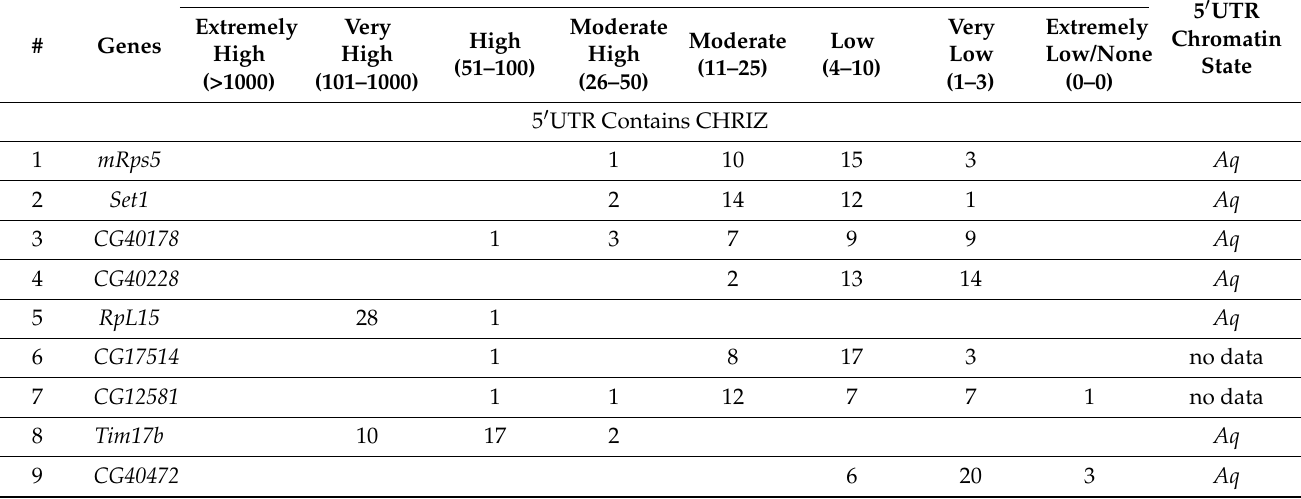
Table 1. Activity of genes localized in D. melanogaster chromosome 3 heterochromatin expressed in RPKM units in the cells of 29 tissues